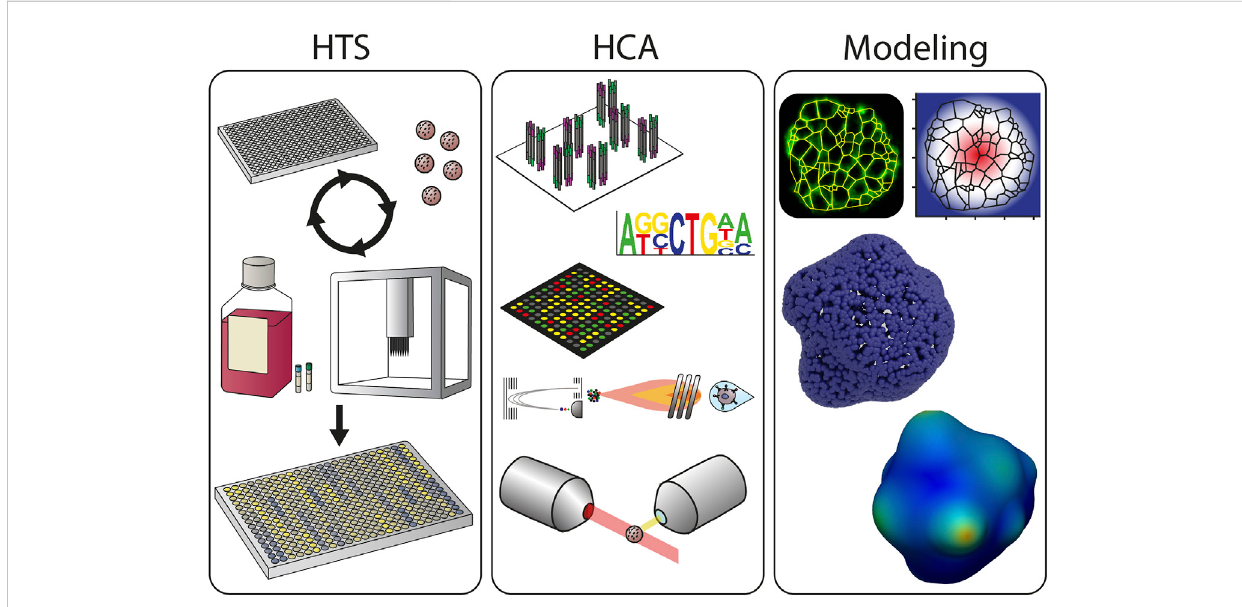
FIGURE 2 Schematic overview of HTS & HCA work fl ow. HTS relies upon on simple culturing protocols, fully compatible with high count microwell platforms and liquid handling automatons. HTS experimental design allows fast readout and automated data processing. HCA is suitable for obtaining a comprehensiveunderstandingoftissueandcellmechanic,utilizing(singlecell)omicsandhigh-resolutionimagingtools.Computationalmodelsareused to examine mechanobiological processes controlling organoid growth, patterning or for validating results from organoid studies. Measurements and features derived from organoid culture are structuring those